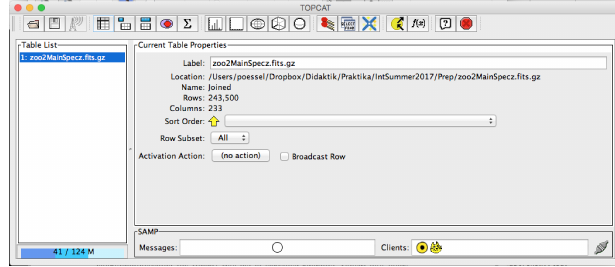
Fig. 52.— TOPCAT after having loaded our file